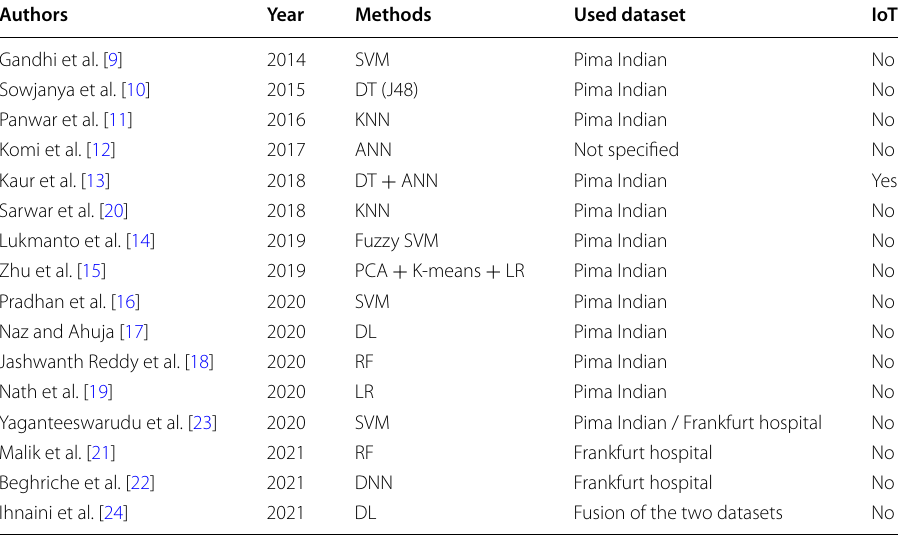
Table 1 Comparison summary of the existent